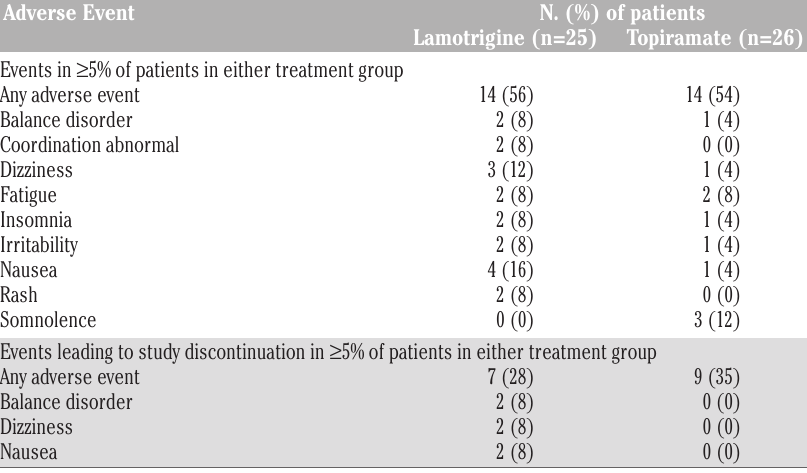
Table 7. Study drug–related treatment-emergent adverse events ( ≥ 5% of patients in either treatment group) and adverse events leading to study discontinuation ( ≥ 5% of patients in either treatment